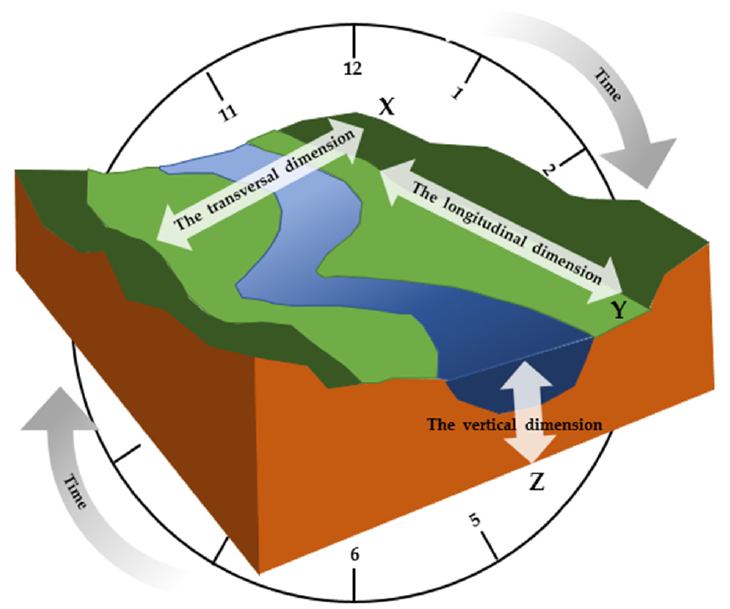
Figure 2. Four-dimensional structure diagram of river ecological corridor [52] (Reproduced with permission from [Dong Z.R.], [Eco-hydraulic Engineering]; published by [China Water Power Press], (2019)). The river ecological corridor includes the transversal dimension, the longitudinal dimension, the vertical dimension, and the time dimension.